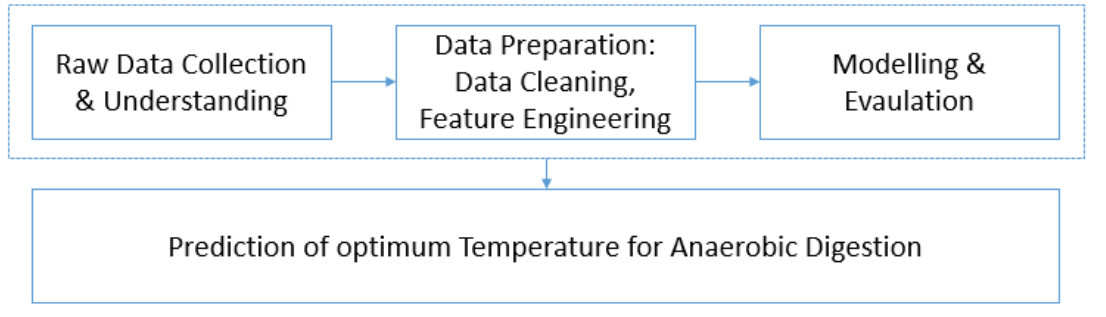
Figure 4. Overview of the methods.